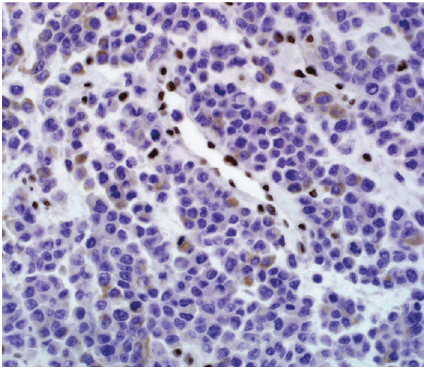
Figure 2: INI1/BAF47 immunostain showing loss of nuclear staining in the rhabdoid cells in comparison to the positive nuclei of the endothelial cells (INI1/BAF47 immunohistochemical stain, magnification power × 200).